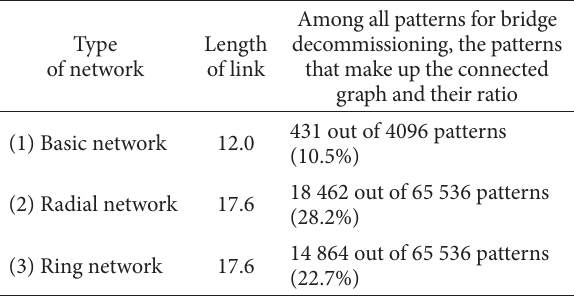
Table 6. Length of link and connectivity of each network type Among all patterns for bridge Type Length decommissioning, the of network of link